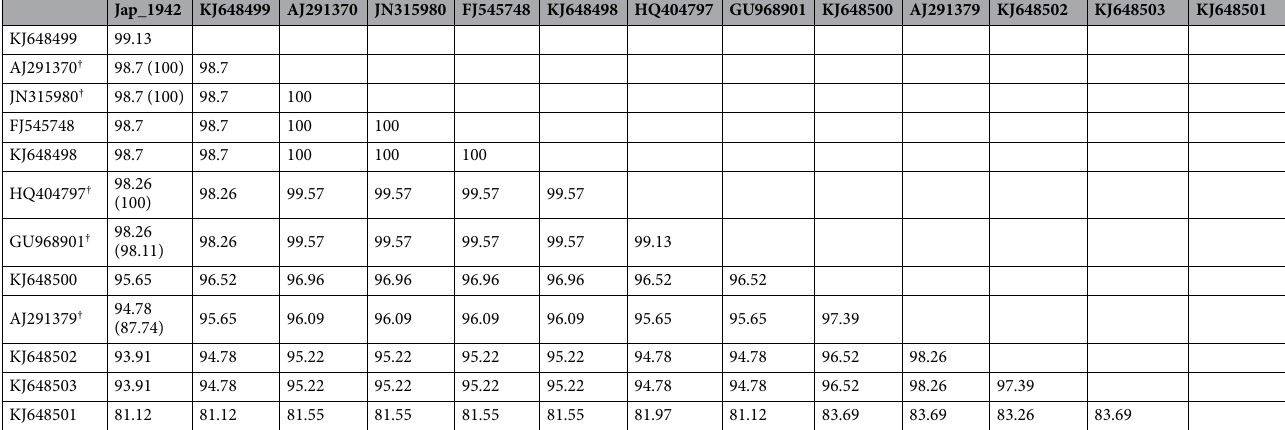
Table 3. Percentage (%) sequence identity of Bemisia species Wolbachia endosymbionts wsp partial gene (230 bp). The Wolbachia wsp partial gene from the historical 1942 Bemisia specimen (‘Jap_1942’) was most similar to KJ648499, which belonged to the W2 Wolbachia strain isolated from invasive (i.e., MED, MEAM1) and native (Asia I, Asia II3, China 2) B . tabaci cryptic species complex. ‘ † ’Indicates the five Wolbachia strains that had sufficient wsp gene sequence at the 5 ′ region to enable sequence identity comparison with the historical Japanese Wolbachia wsp gene (sequence identity acorss these 5 ′ end of 106 bp are indicated within parentheses). Note : GenBank accession numbers provided for Wolbacia strains W1 (KJ648498), W2 (KJ648499), W3 (KJ648500), W4 (KJ648501), W5 (KJ648502), and W6 (KJ648503) are as reported by ref.